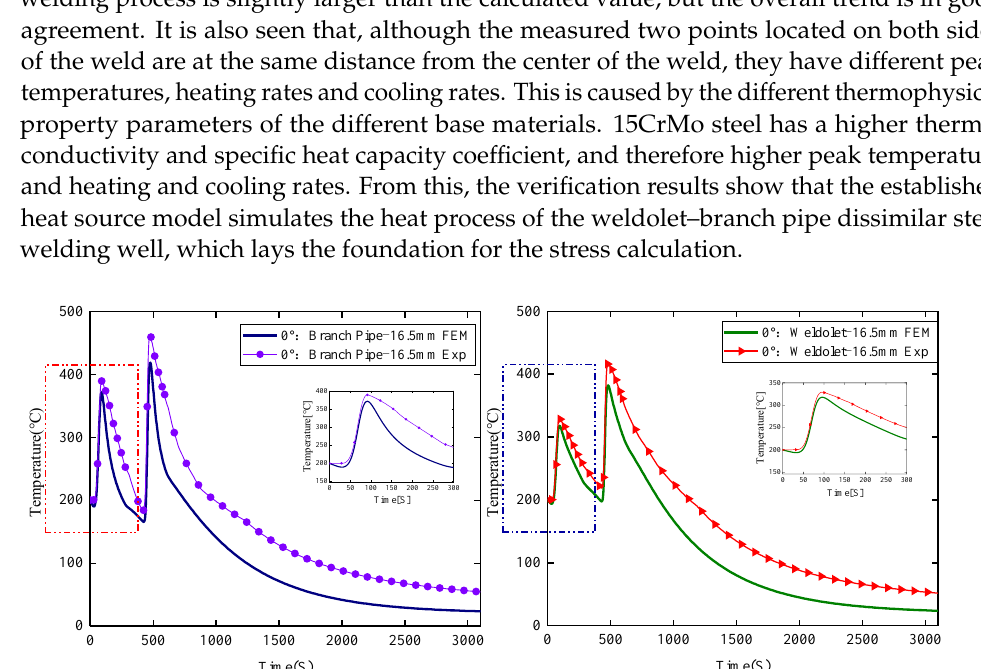
Figure 8. The shape of the weld pool obtained through experiments and finite element simulations.